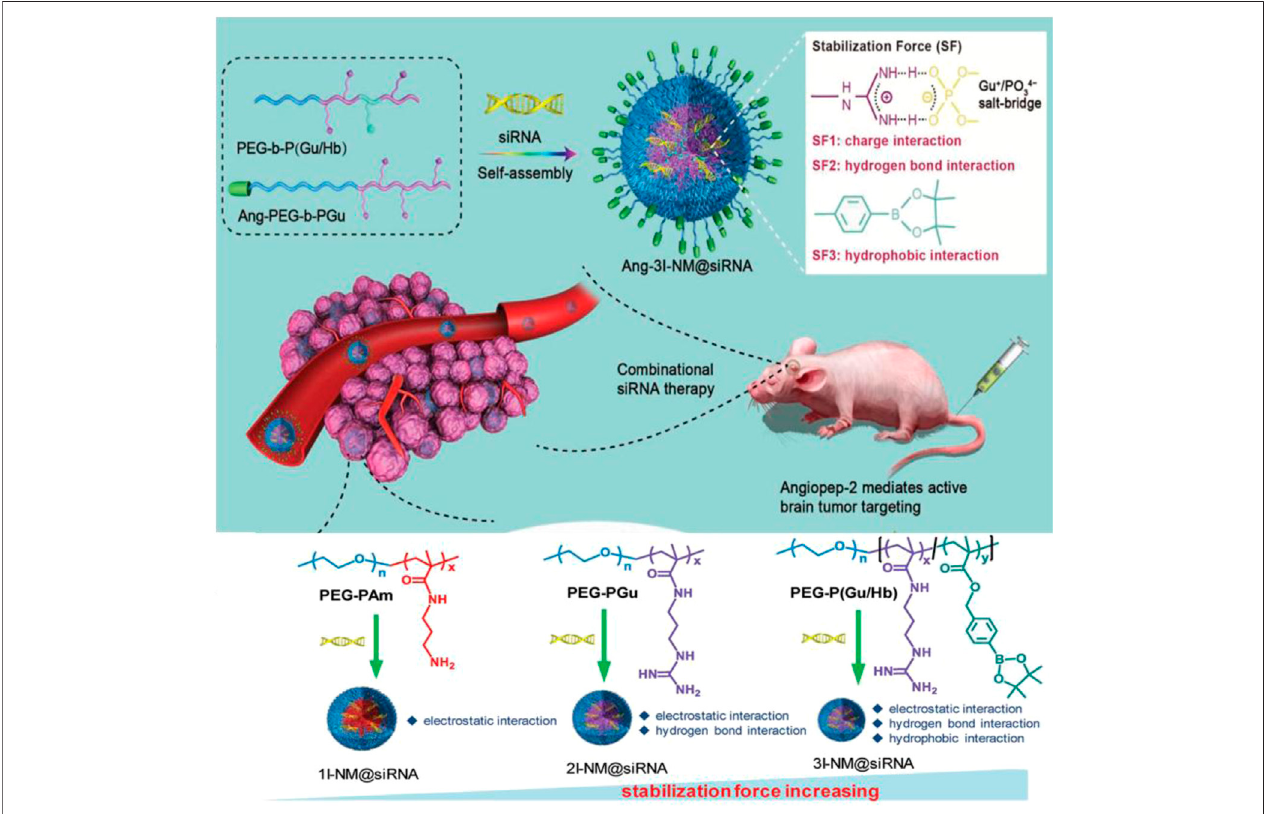
FIGURE 11 | Schematic illustration of 3I-NM@siRNA stabilized by electrostatic, hydrogen bond and hydrophobic interactions. The chemical structures of poly(ethylene glycol)-blockpoly (N-(3-aminopropyl methacrylamide) (PEG-Pam), poly(ethylene-glycol)-block-poly(N-(3-methacrylamidopropyl) guanidinium) (PEG-b- PGu), and PEG-B-P (Gu/Hb) (Zheng et al., 2019). Copyright 2019, John Wiley and Sons.